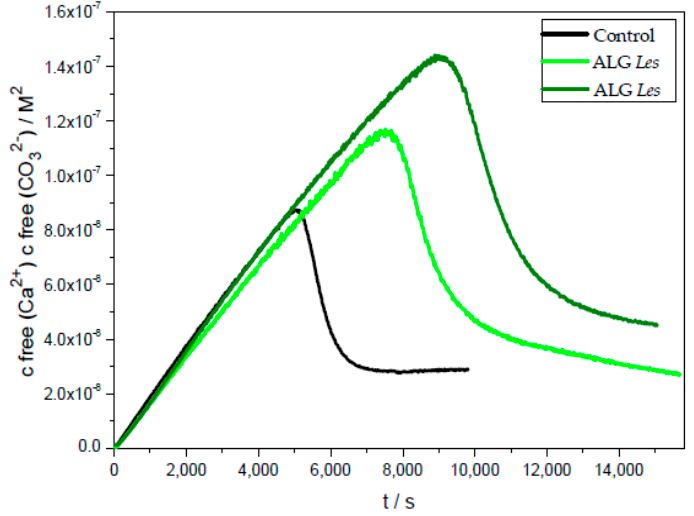
Figure 5. Time development of CaCO 3 solubility products using two concentrations of ALG Les at pH 9.0: blank ( black line ), 5 mg/L ALG Les ( green line ) and 10 mg/L ALG Les ( olive line ).